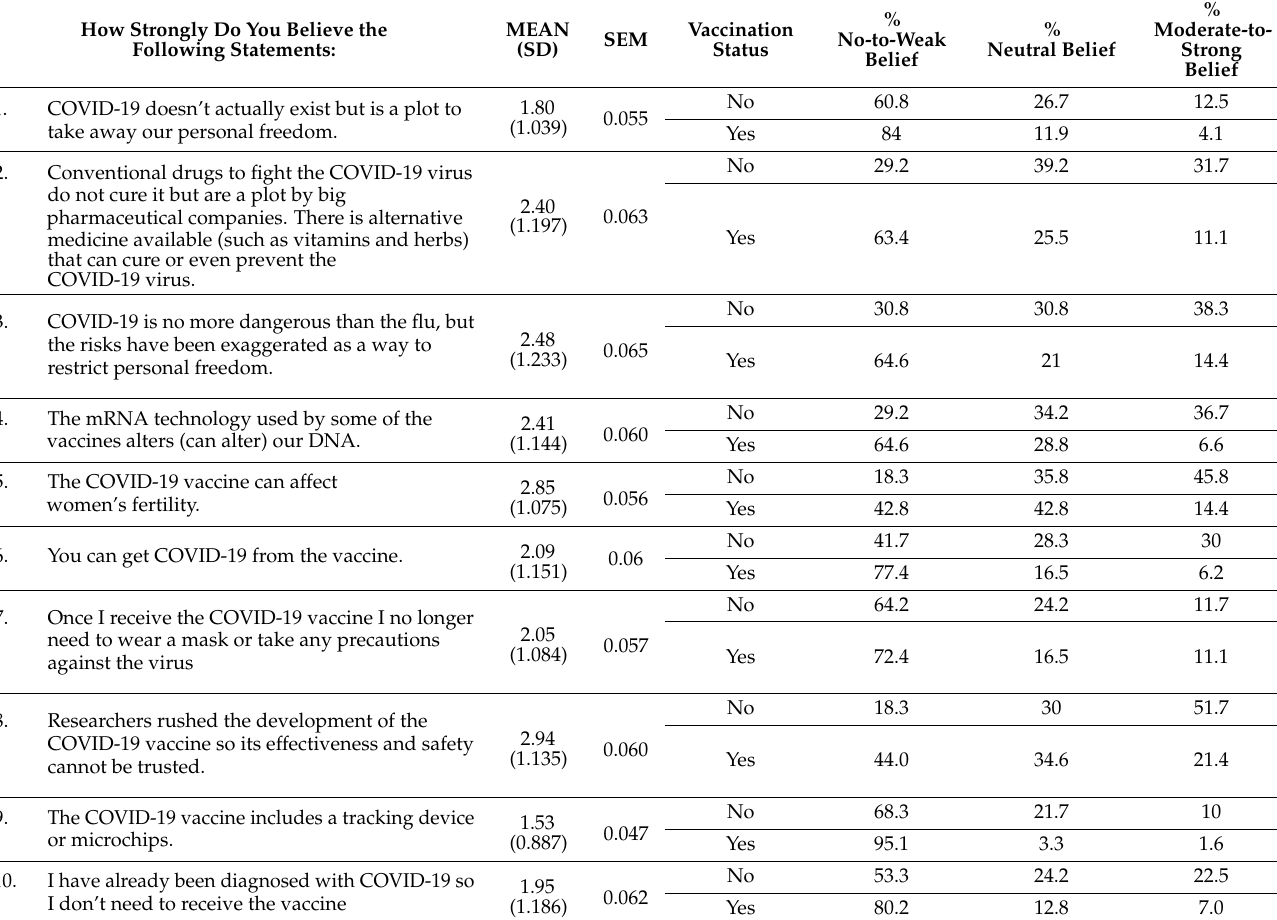
Table 2. Mean response and percentage of no-to-weak, neutral, and moderate-to-strong belief for each conspiracy theory statement based on vaccination